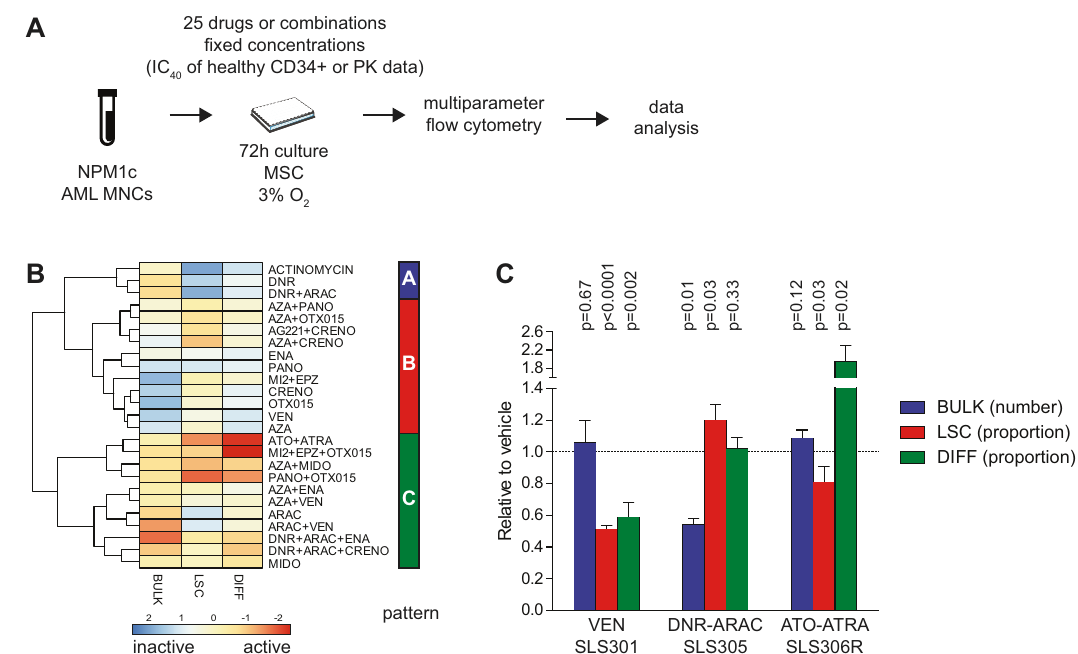
Fig. 2 Different patterns of drug activity at clinically relevant concentrations. A Work fl ow of ex vivo drug screening of primary NPM1- mutated AML MNCs with 25 drugs or combinations at fi xed, clinically relevant drug concentrations nominated based on published pharmacokinetics data or on dose – response assays in healthy CD34 + cells. B Heatmap of drug activity patterns for one illustrative case (SLS305, relapsed AML with trisomy 4 and NPM1 mutation) displaying the number of residual cells in the leukemic bulk (BULK), the proportion of GPR56 + /Diff − LSCs and that of GPR56 − /Diff + differentiating cells (DIFF). Results of the heatmap are displayed after scaling per output so that higher arbitrary values indicate a lower number of bulk leukemic cells, a lower proportion of LSCs, and a higher proportion of DIFF cells, hence higher drug activity. C Illustrative output of single-agent venetoclax (VEN), DNR-AraC, or ATO-ATRA in the three NPM1 -mutant tested samples (SLS301 relapsed AML with isolated del(15q), NPM1 , DNMT3A , RAD21 , CUX1 , NRAS , KIT, and GATA2 mutations; SLS305 as supra ; SLS306R relapsed AML with complex karyotype, NPM1 , FL3 -ITD, DNMT3A, and SMC3 mutations, details on patient samples and gene mutations are provided in Supplementary Tables 1, 2). Results are shown normalized to DMSO vehicle wells. Mean ± SD of technical triplicates. Unpaired two-sided t of 21 tested amino acids (false discovery rate [FDR] < 0.01, Fig. 3A, Supplementary Table 5). Myeloid cytokine levels were highly variable in AML conditioned media but were systematically lower than BM plasma levels for TPO (mean 62.2 ± 61.1 versus 1128.2 ± 1012.9 pg/mL, q = 0.001) and EPO (mean 29.9 ± 7.9 versus 2852.0 ± 4506.0 pg/mL, q < 0.001, Fig. 3B, Supplementary